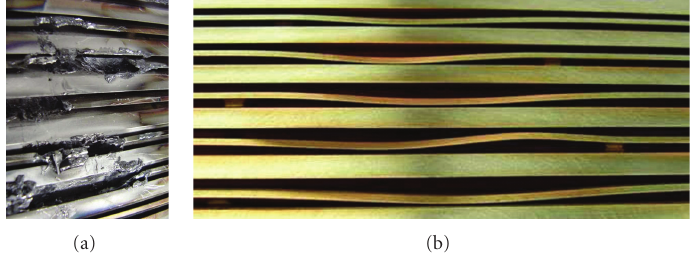
Figure 7: Failure of the chevron slot structure combined with thin blades, structure shown in Figure 4. Photo (a) shows overheated slots structure followed by slot’s melting (Al), and (b) thin blade deformation due to the expansion as their temperature increased relatively to the temperature of a more robust and cooled chevron